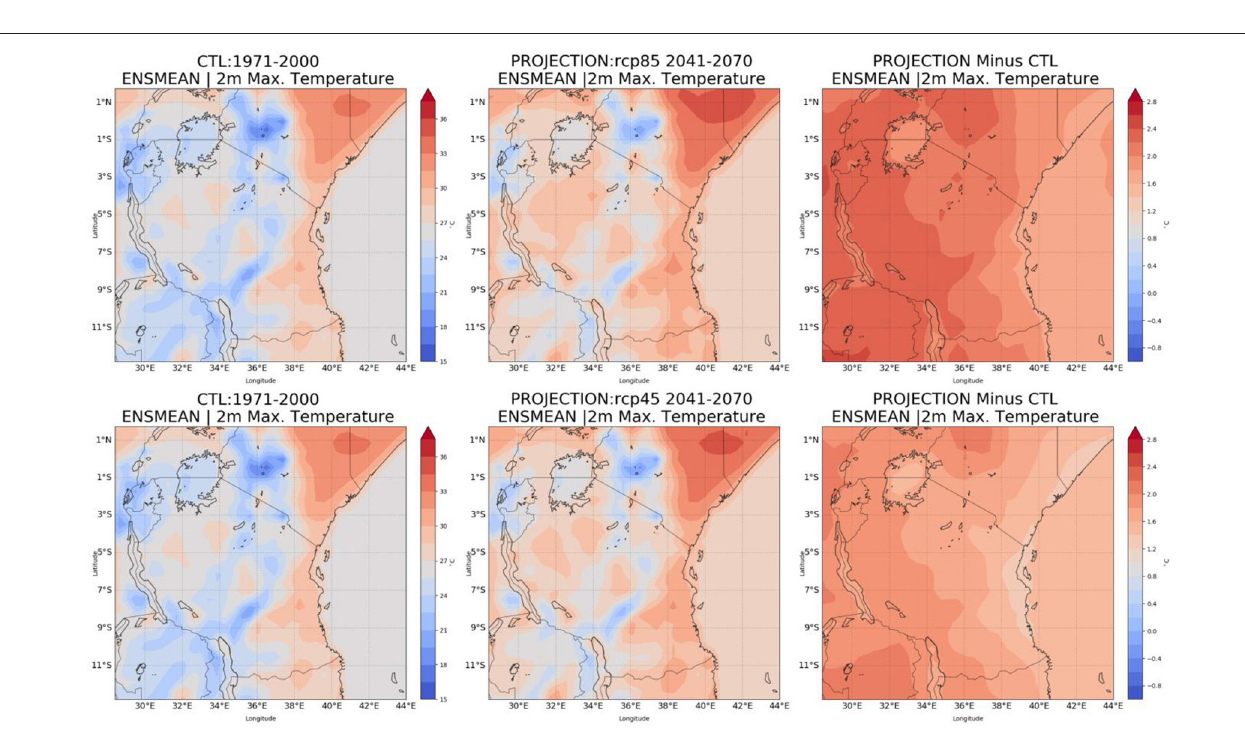
Frontiers in Environmental Science |